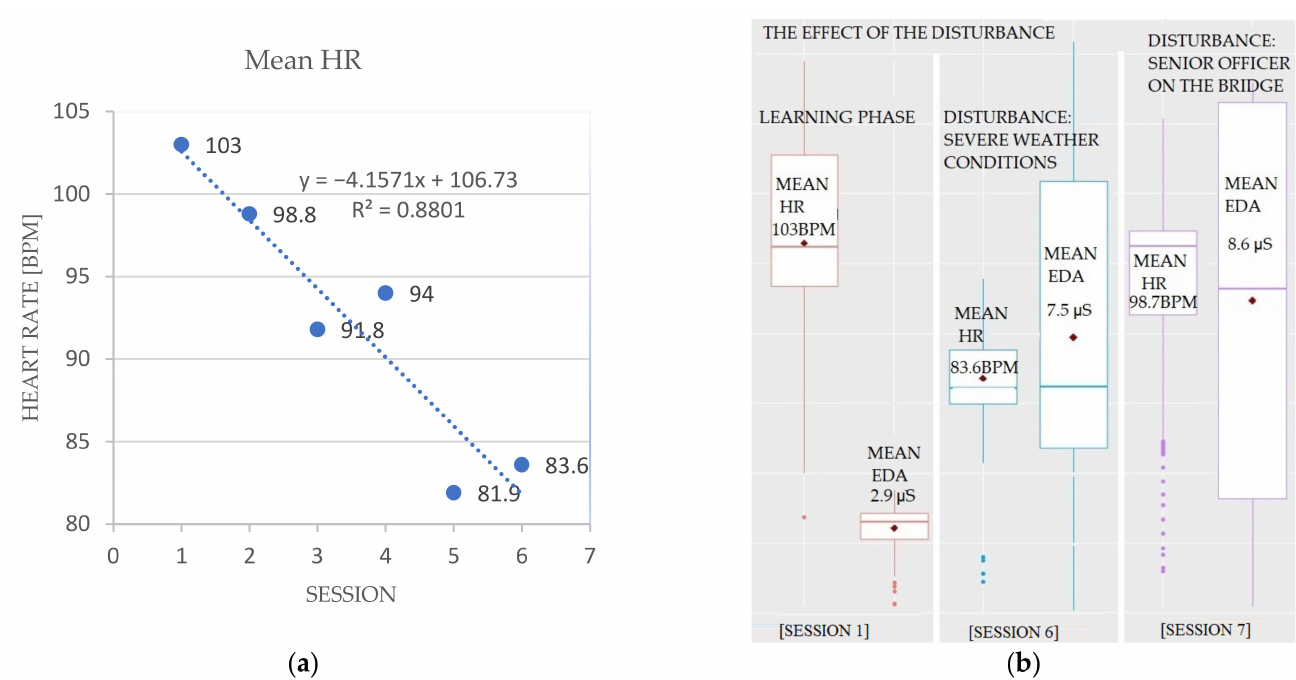
Figure 5. Observing the mean response of one of the experienced participants during seven simula- tions. The experience gained through the learning period reasoning decreased the HR ( a ); the EDA response correlates with the repetitions. The severe weather conditions in session 6 induced a higher EDA response. Session 7 shows an even higher response due to the instructor’s comments during the experiment ( b ).